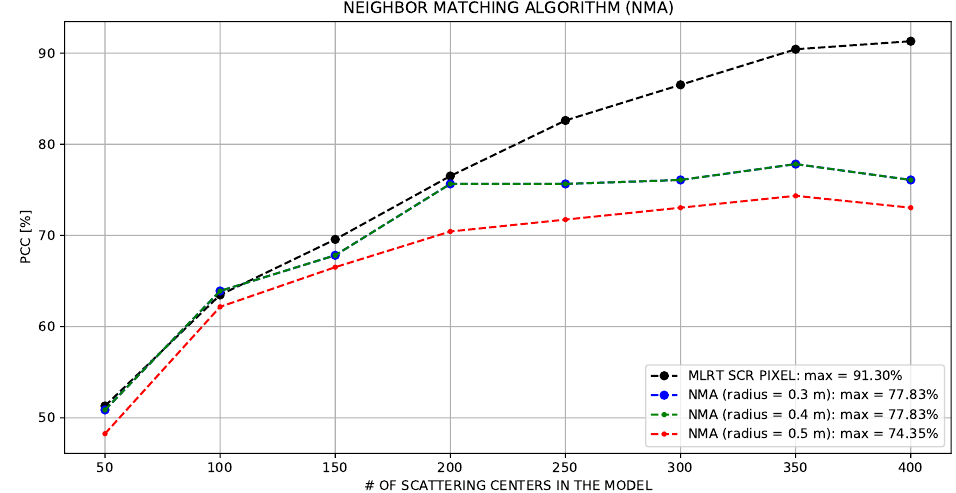
Figure 20. Comparison between the Neighbor Matching and the proposed